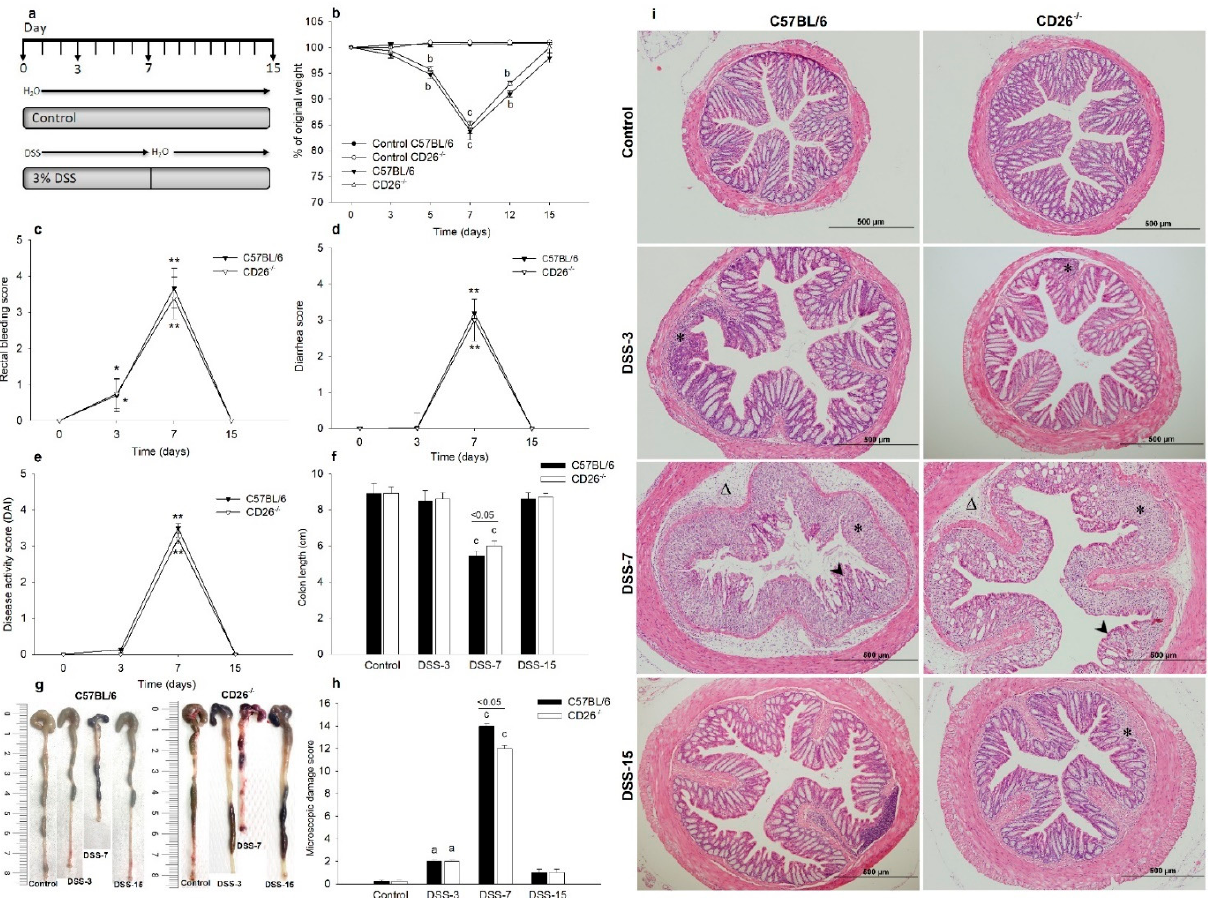
Figure 1. Clinical and histological changes during acute dextran sulfate sodium (DSS)-induced colitis and healing period in C57BL/6 and CD26-deficient (CD26 − / − ) mice. ( a ) Schematic illustration of the experimental protocol over time. C57BL/6 and CD26 − / − mice were administrated to DSS in drinking water from day 0 to day 7 followed by the administration of tap water during the recovery period until the end of the experiment on day 15. Mice were sacrificed on days 3, 7, and 15. The control group received tap water throughout the 15 days of the experiment. ( b ) Changes in the body weight were calculated as the percentage of initial body weight ± SD. ( c ) Rectal bleeding scores. ( d ) Diarrhea scores. ( e ) Disease activity scores (DAI). ( f ) The length of the colon. ( g ) Representative macroscopic images of the colon of DSS-treated C57BL/6 and CD26 − / − mice on days 3, 7, and 15 of the experiment and their respective controls. ( h ) Microscopic damage score of the colonic sections